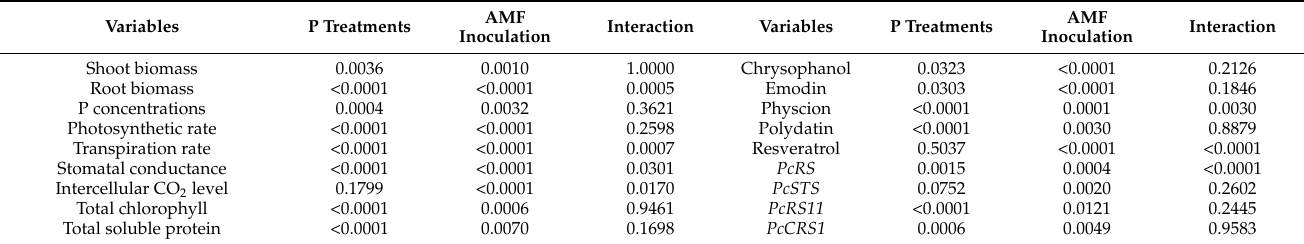
Table 2. Interacted significance of variables.